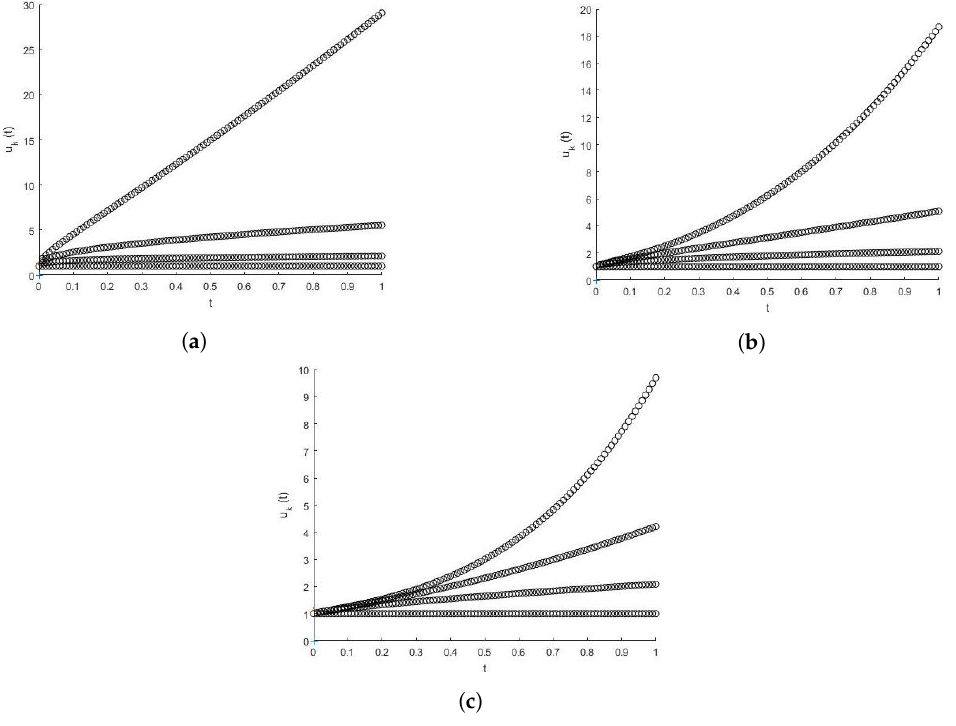
Figure 1. Graphs of c D q u = u 2 , u ( 0 ) = 1 from t = 0 to t = 1. ( a ) Graph of c D .25 u = u 2 , u ( 0 ) = 1. ( b ) Graph of c D .5 u = u 2 , u ( 0 ) = 1. ( c ) Graph of c D .75 u = u 2 , u ( 0 ) = 1.